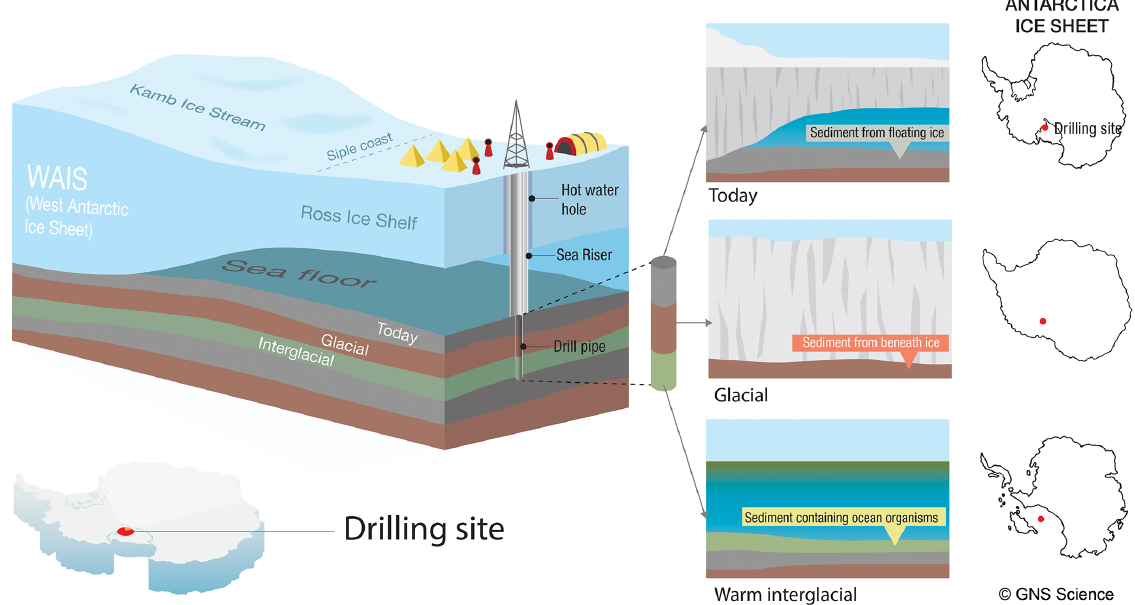
Figure 5. Diagram showing new drilling system sitting on the floating Ross Ice Shelf near the grounding zone at the Kamb Ice Stream site. A drill string up to ∼ 1000m long will be lowered to the seafloor through a hot-water drilled hole in the ice shelf to core ∼ 200m into the seafloor to sample sediments deposited in the